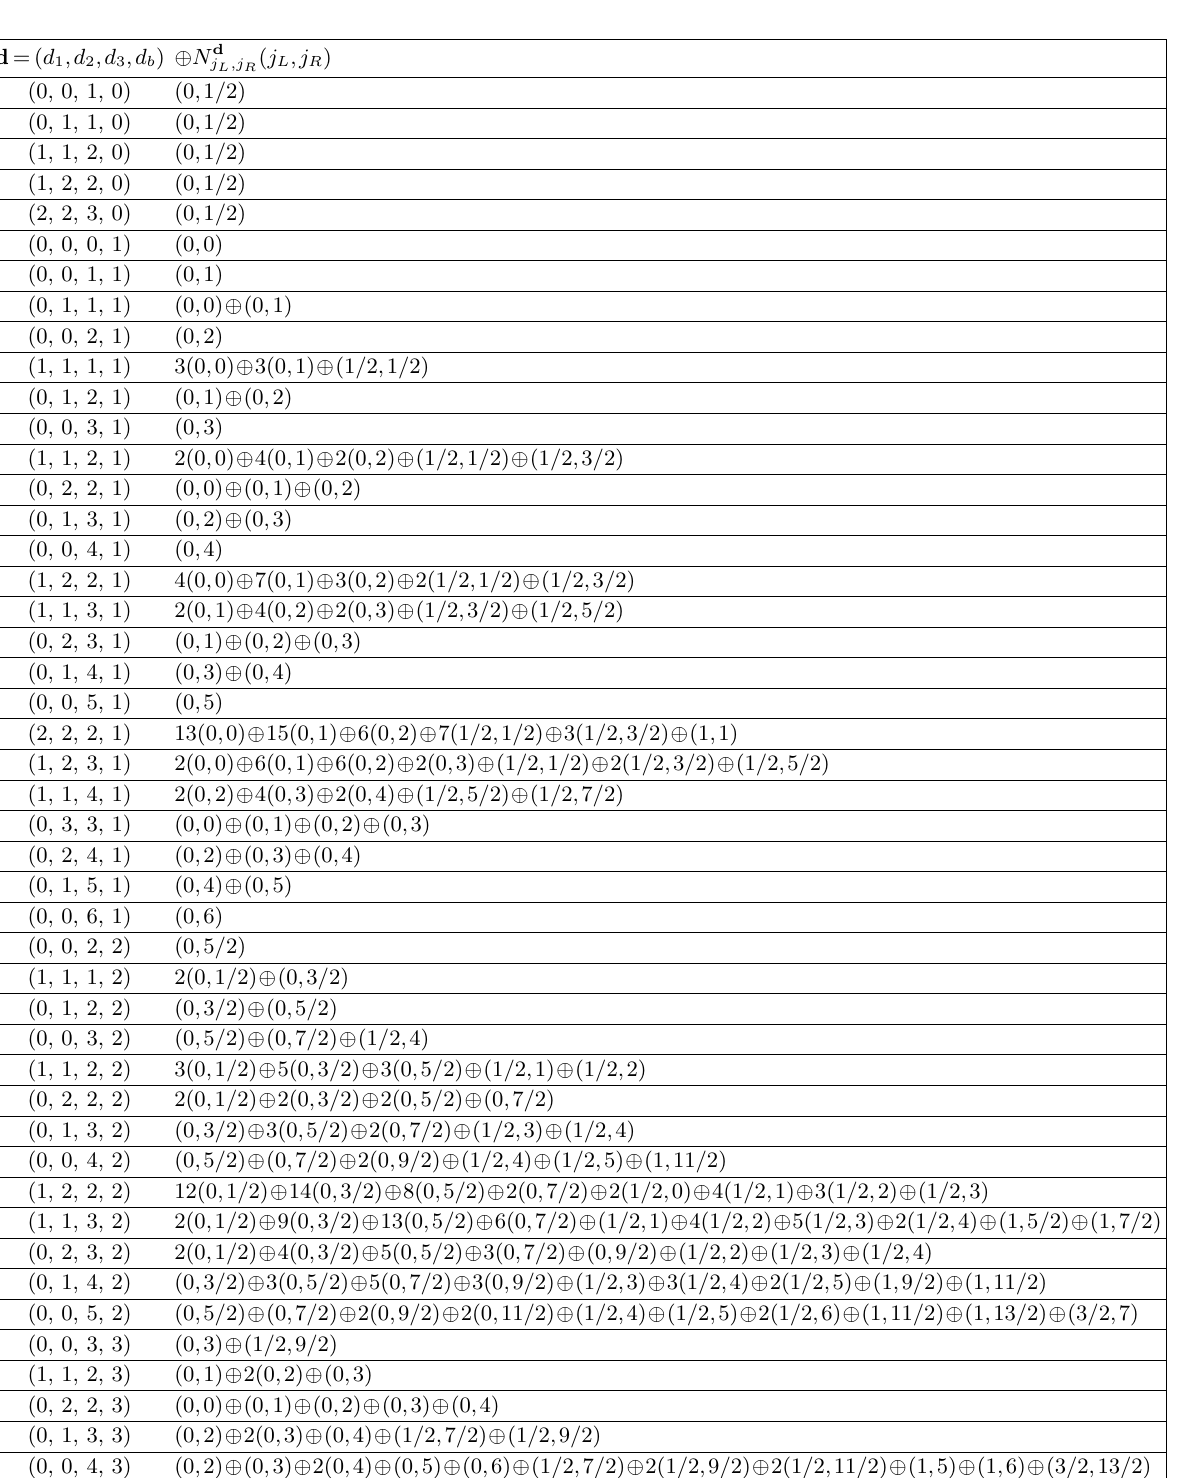
Table 5. BPS invariants of 6d n = 3 minimal